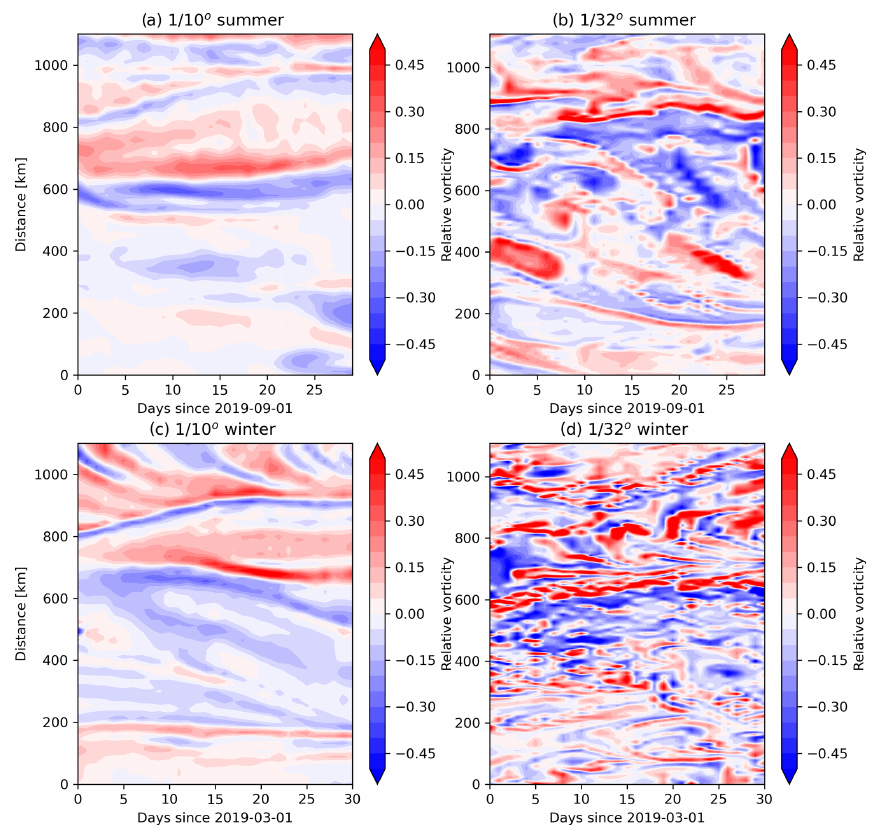
Figure A3. Hovmöller diagram of surface relative vorticity along a section in the Kuroshio Extension region, marked as black line shown in Fig.